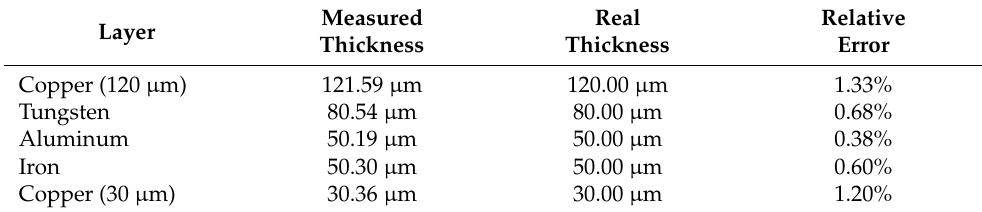
Figure 11. Simulation results of displacement at the ring center and comparison of peak-to-peak amplitudes of the focal shear echoes when R varies near ( a ) 80 μ m, ( b ) 150 μ m, and ( c ) 180 μ m. Table 2. Layer thickness measurement results.